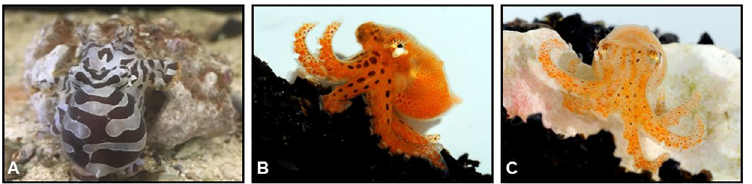
Fig 1. Photographs depicting Octopus chierchiae of different ages. (A) One-year-old O . chierchiae adult. (B) One- day-old O . chierchiae hatchling. (C) Five-day-old O . chierchiae hatchling already displaying a developing stripe configuration.